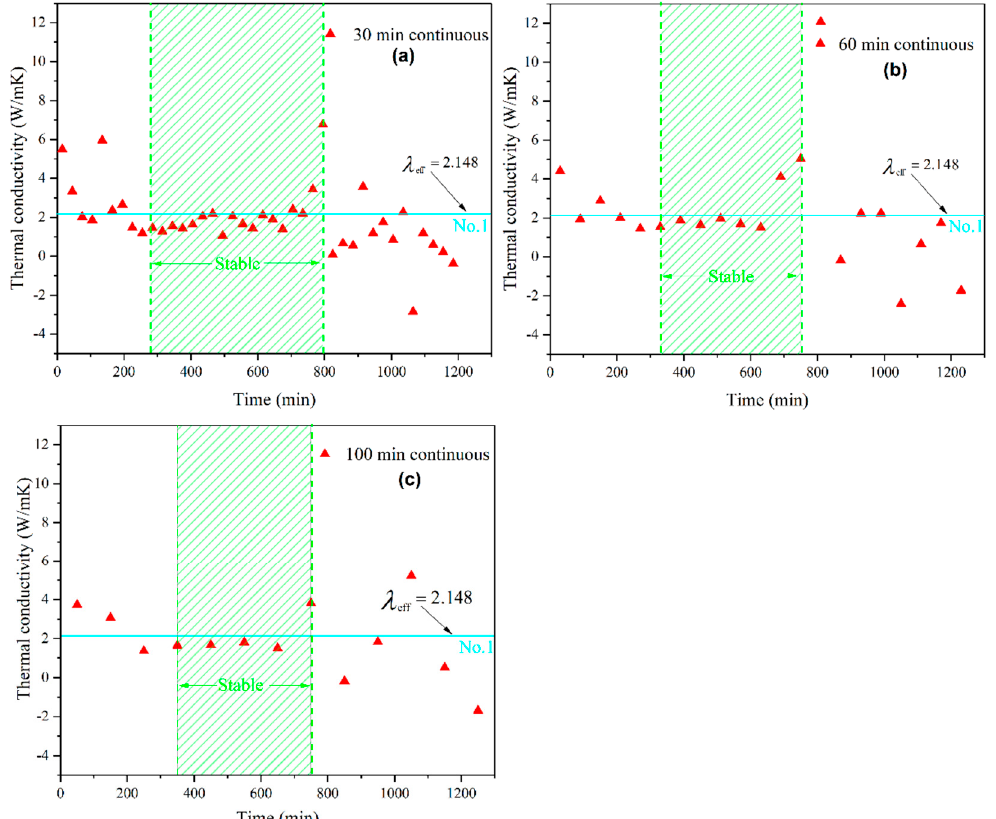
Figure 8. Calculated effective ground thermal conductivity estimated by deploying Non-superposition segmented data in time continuous method. ( a ) 30 min, ( b ) 60 min, ( c ) 100 min.